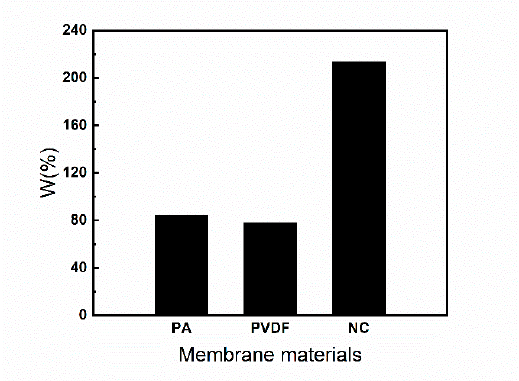
Figure 9. The coefficient of water absorption (W) of three MFMs.